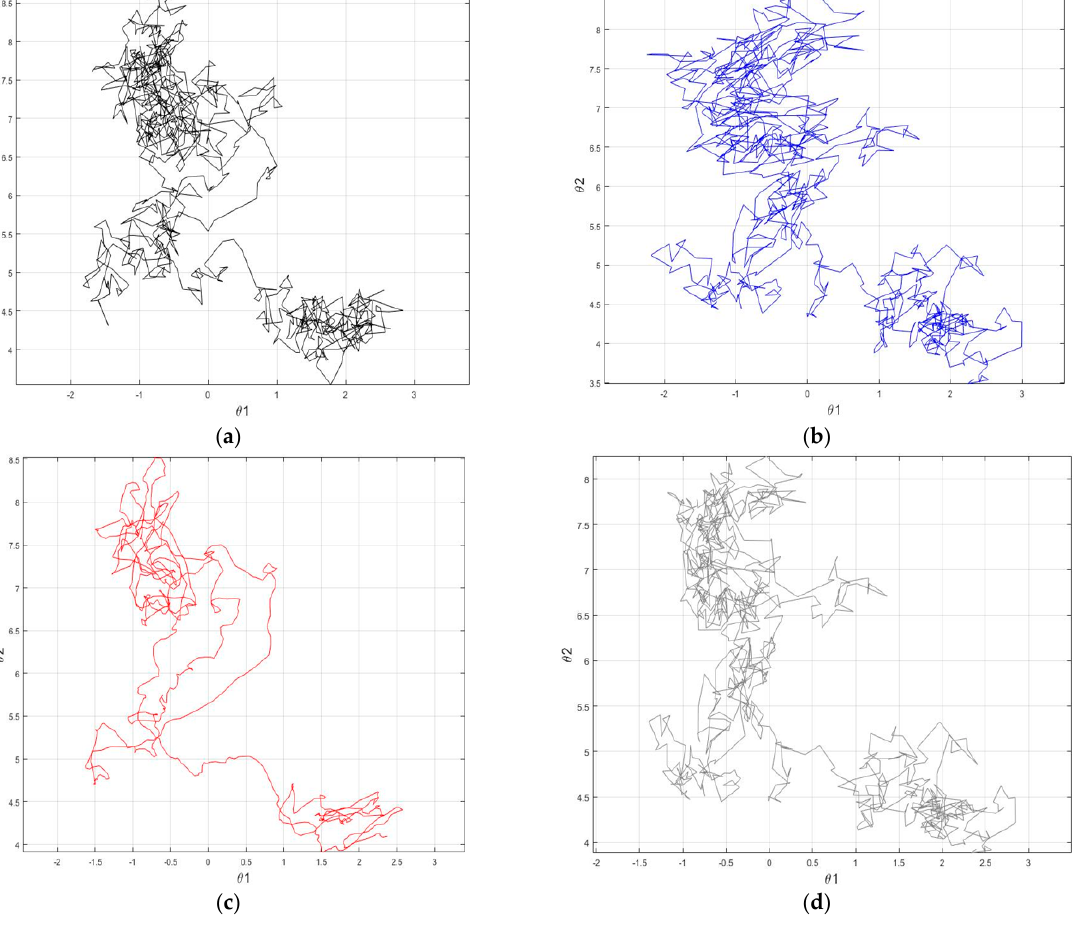
Figure 5. Different models’ paths in 2D: ( a ) clean data [26], ( b ) DMK drone path, ( c ) PF drone path, and ( d ) UEAKF drone path.